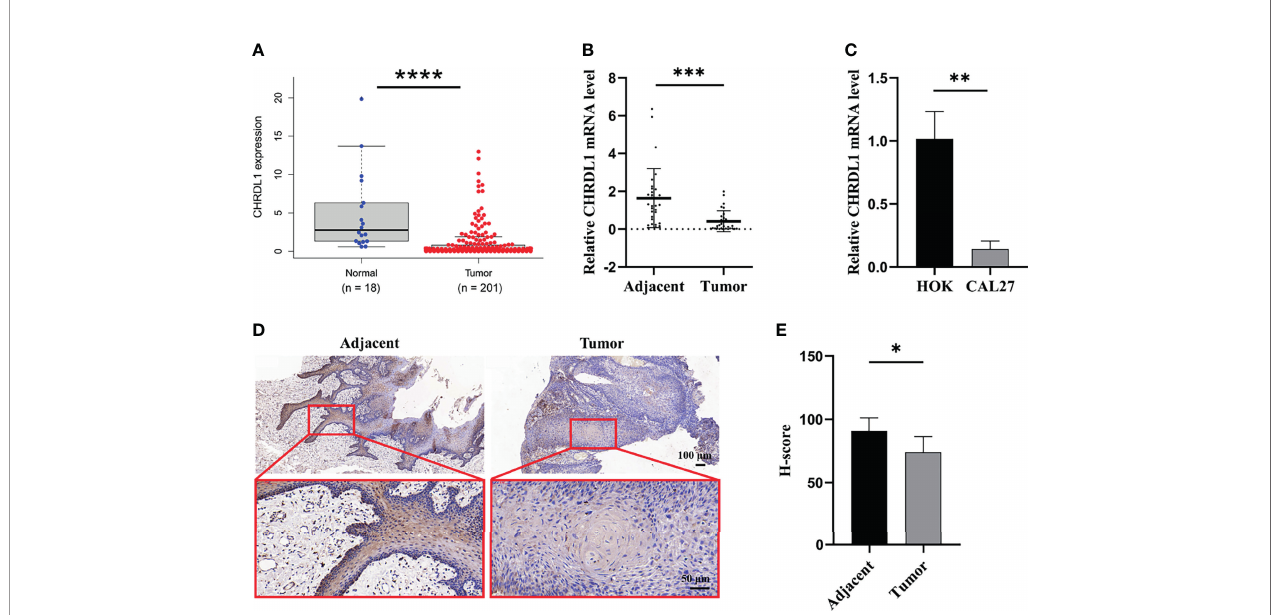
FIGURE 1 | The expression of CHRDL1 was downregulated in OSCC tissue and cell lines. (A) Relative mRNA expression of CHRDL1 in OSCC tissues ( n = 201) and normal tissues ( n = 18) from the TCGA database. (B) The relative mRNA expression of CHRDL1 in 30 specimens of OSCC and adjacent tissues was determined by qRT-PCR. (C) The relative mRNA expression of CHRDL1 in normal human oral keratinocytes (HOK) and the OSCC cell line CAL27 was determined by RT-qPCR. CHRDL1 mRNA expression was normalized to GAPDH. (D, E) IHC analysis of CHRDL1 in tumor and adjacent tissues ( n = 5). Error bars represent the standard deviation. * p < 0.05, ** p < 0.01, *** p < 0.001, **** p <